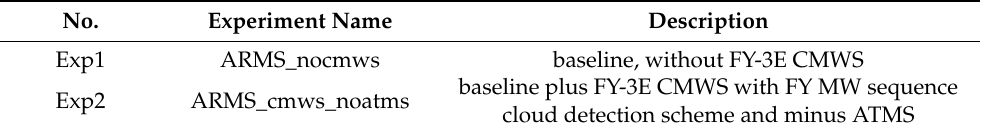
Table 4. The list of assimilation